Question: According to the figure, is the described quantity increasing or decreasing?
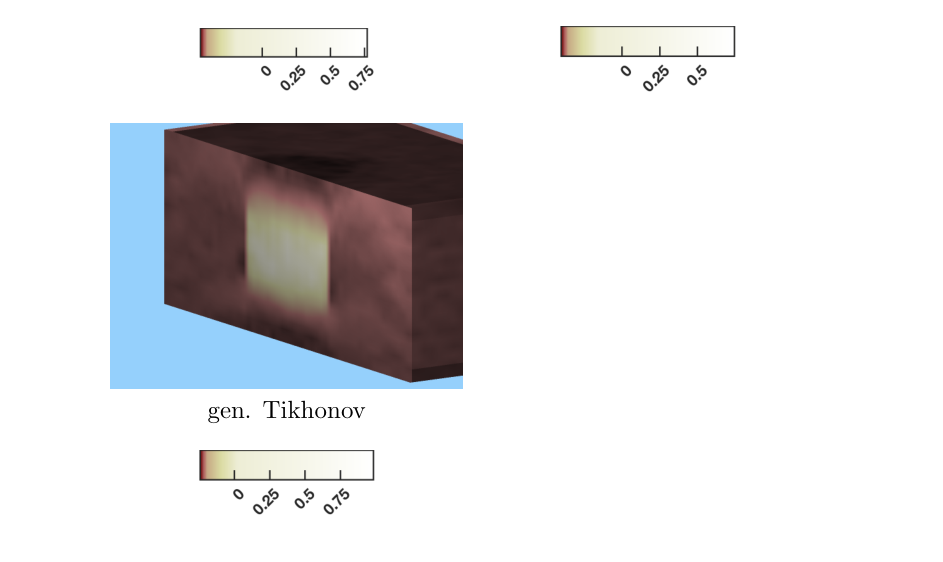
Answer: increasing